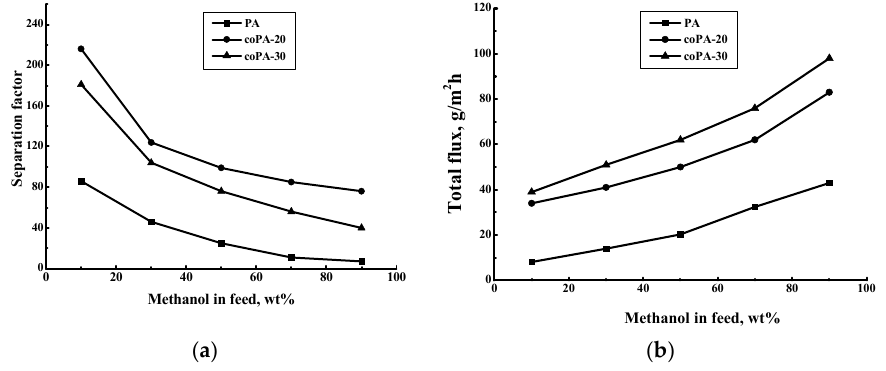
Figure 6. Dependence of ( a ) separation factor α Methanol/Toluene and ( b ) total flux on methanol concentration in the feed for the pervaporation of a methanol–toluene mixture, 20 °C.